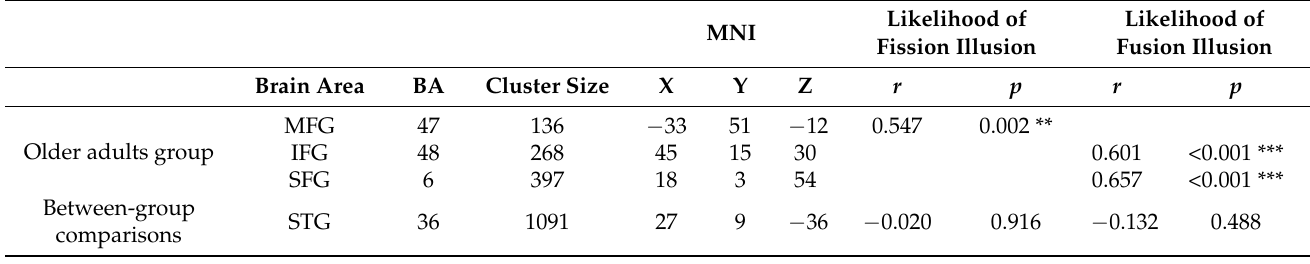
Table 1. Correlation between ReHo values and the likelihood of illusions.